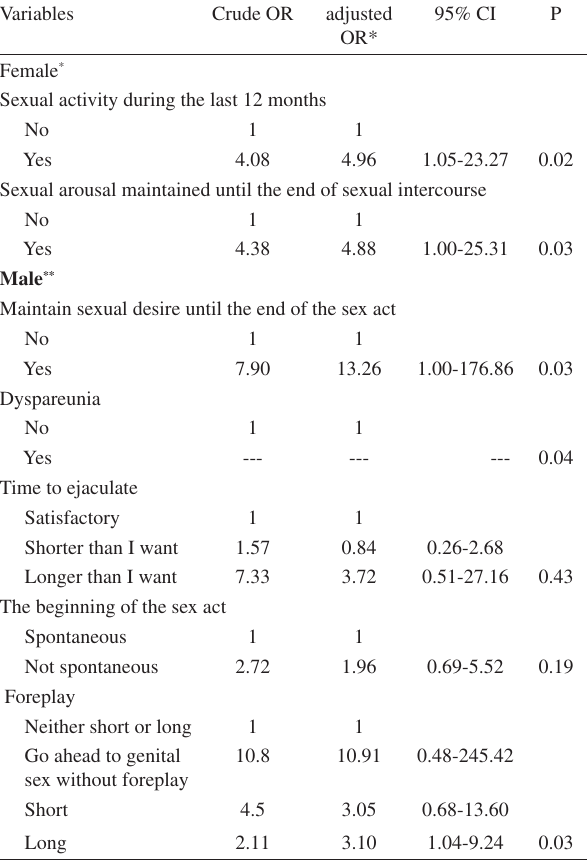
Table 4 - Univariate and multiple logistic model of case and control groups according to sexual